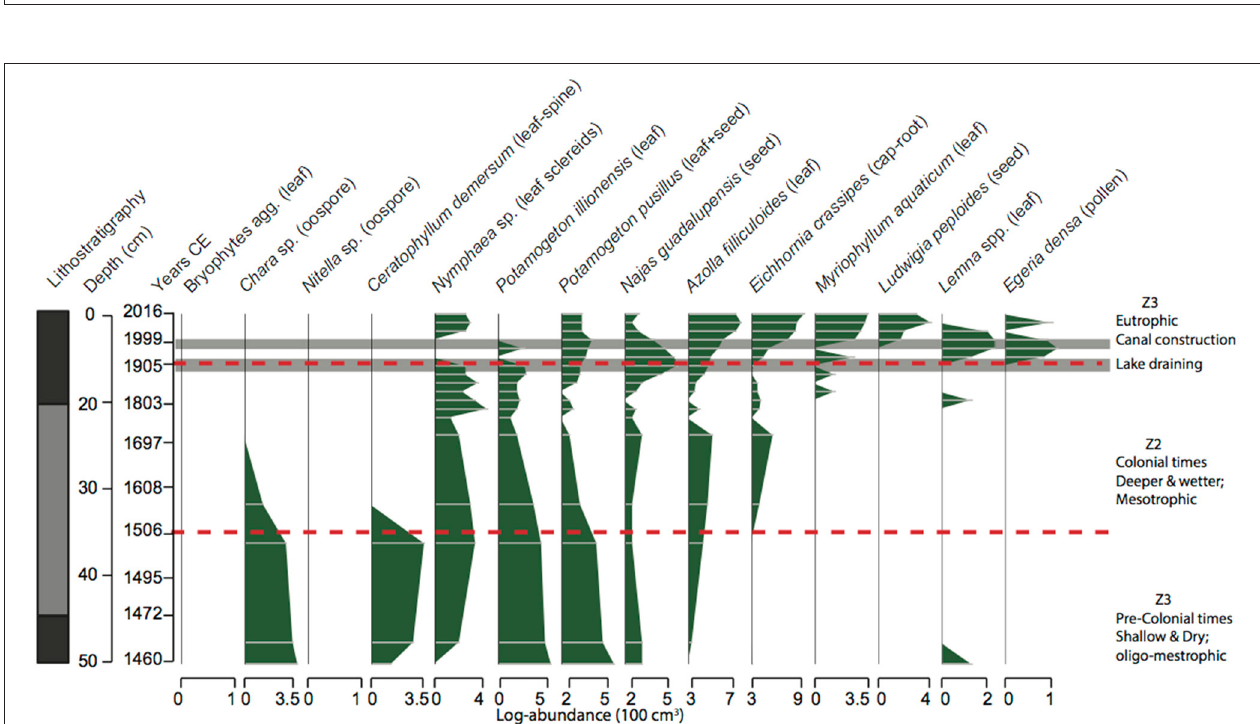
FIGURE 5 | Lithostratigraphy profile (dark gray, organic rich sediments; pale gray, low organic sediments) and plant macrofossil stratigraphy for the core LFUQ-M1. Dotted lines represent zones of macrophyte change revealed by univariate regression tree analysis. Z1 CE c.pre-1506; Z2 CE 1506-1904; Z3 1905 CE-present.